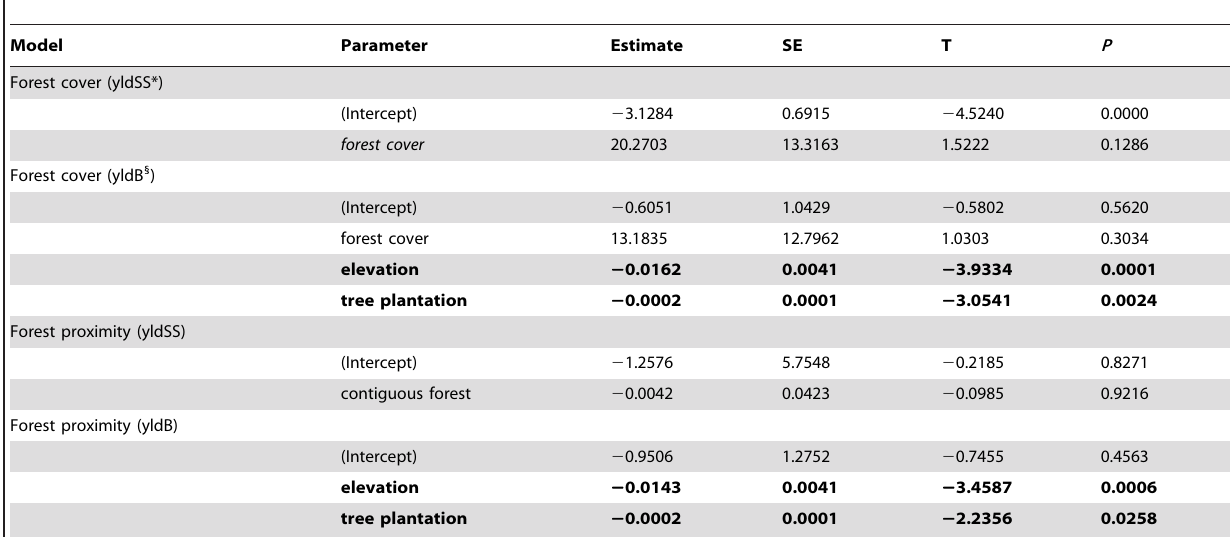
Table 2. The estimates and parameter coefficients from the minimum adequate generalised least square models testing the effects of forest cover and forest proximity on oil palm yield across the study landscape in Sabah, Malaysian Borneo.